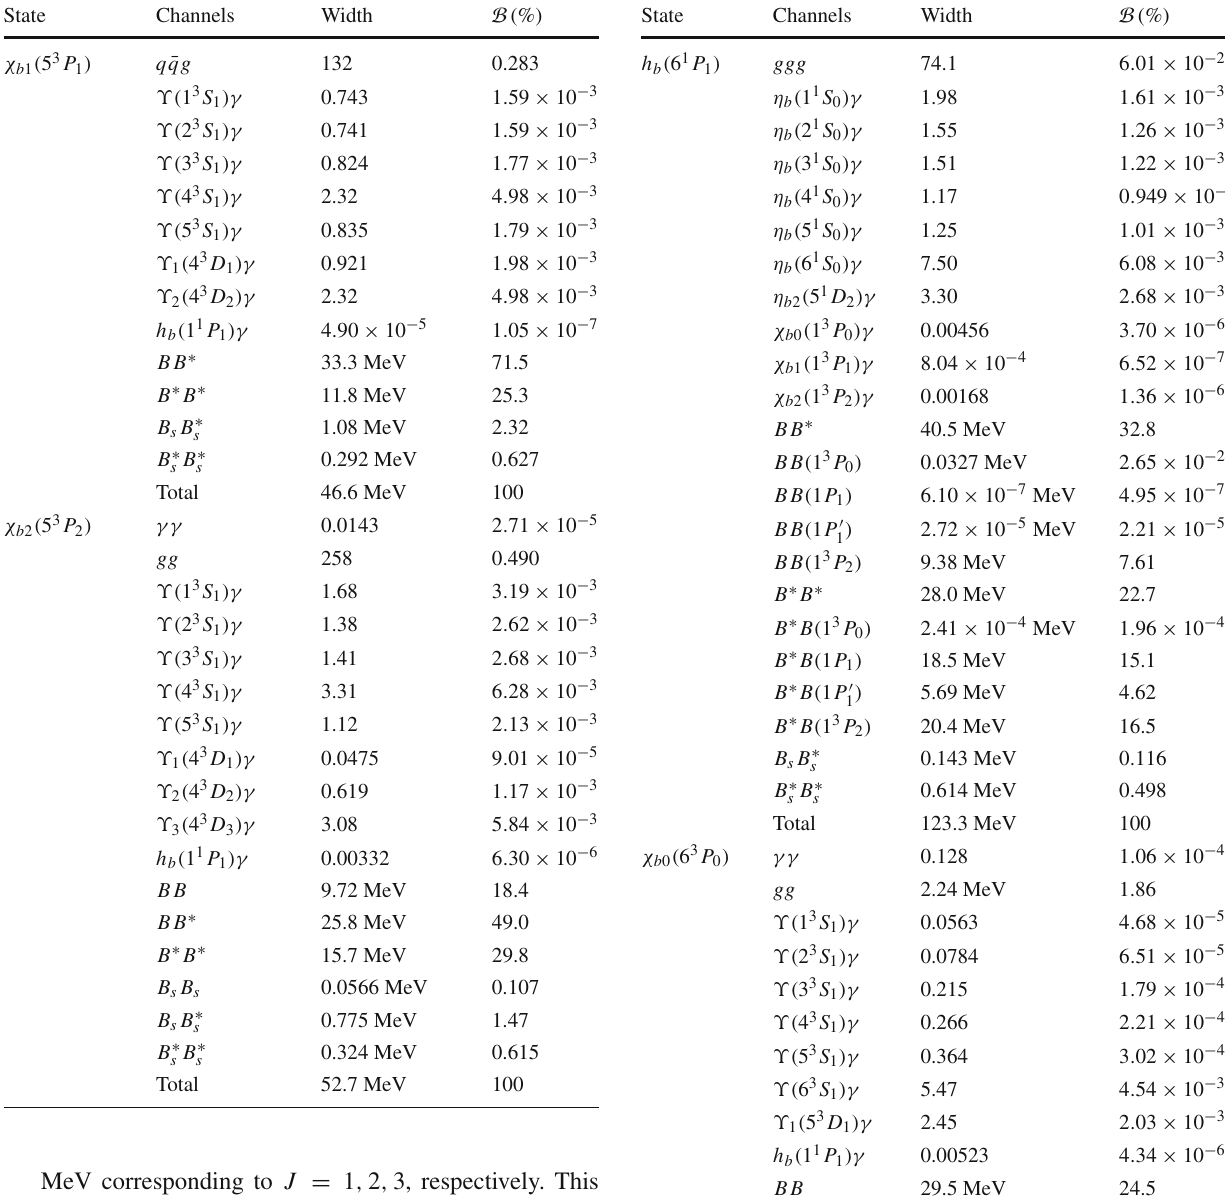
Table 25 Partial widths and branching ratios of OZI-allowed strong decay, annihilation decay, and radiative transition and the total widths for 6 1 P 1 and 6 3 P 0 bottomonium states. The width results are in